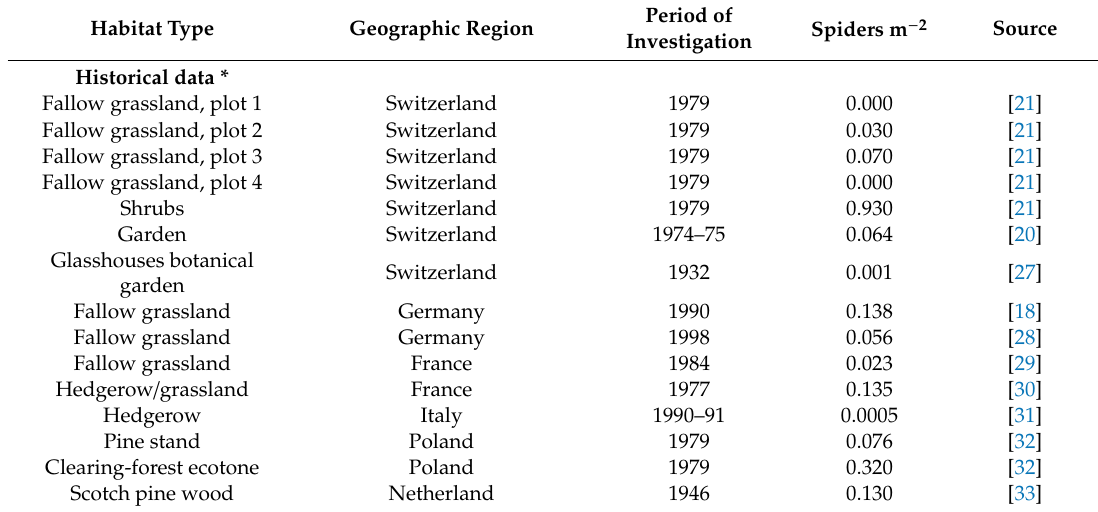
Table 1. Population densities of adult female Araneus diadematus (18 historical vs. 20 recent values). *Adults / subadults in